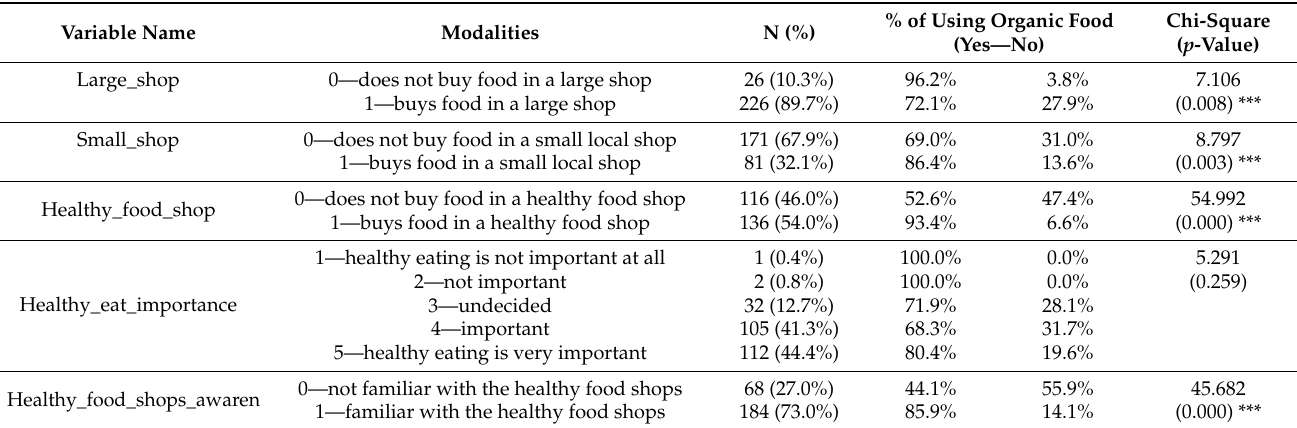
Table A2. Healthy eating awareness and healthy eating